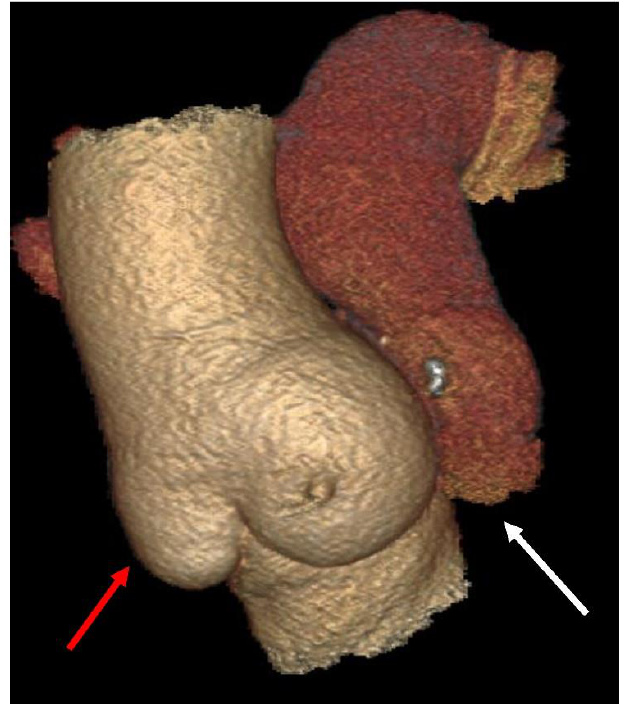
Figure 2. Ross operation after 23 years. Pulmonary autograft ( red arrow ), pulmonary homograft ( white arrow ).